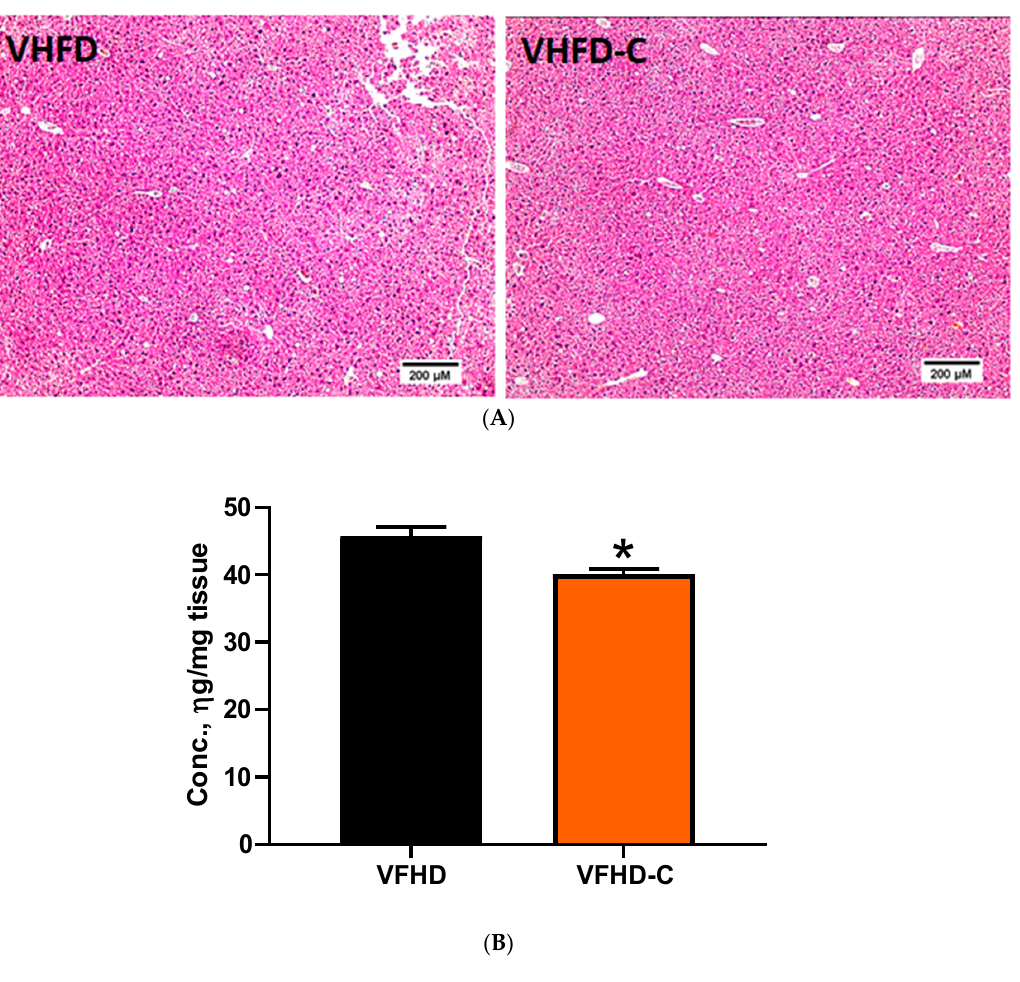
Figure 5. Curcumin effects on liver metabolism in liver. ( A ) Photomicrograph of depicting fat deposition in the liver. Representative images of H&E stained sections. Magnification 100 ×; n = 4. ( B ) Quantification of triglyceride content. Data of colorimetric assay. * indicates a significant difference at p value ≤ 0.05. p value 0.005; n = 9–10.